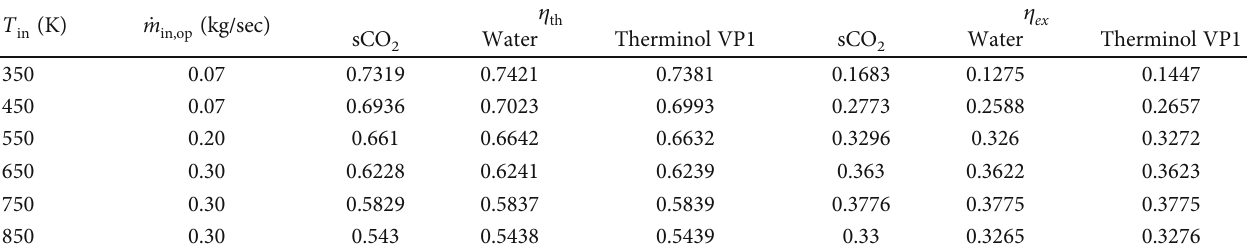
Table 4: Optimum operating conditions for the three examined HTFs at di ff erent inlet temperatures.